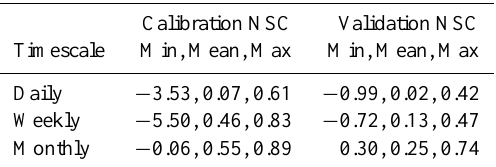
Table 9. Nash–Sutcliffe coefficient (NSC) between observed and simulated water volume at daily, weekly, and monthly timescales. The minimum, mean and maximum values across the 50 ensemble members are reported for the calibration and validation